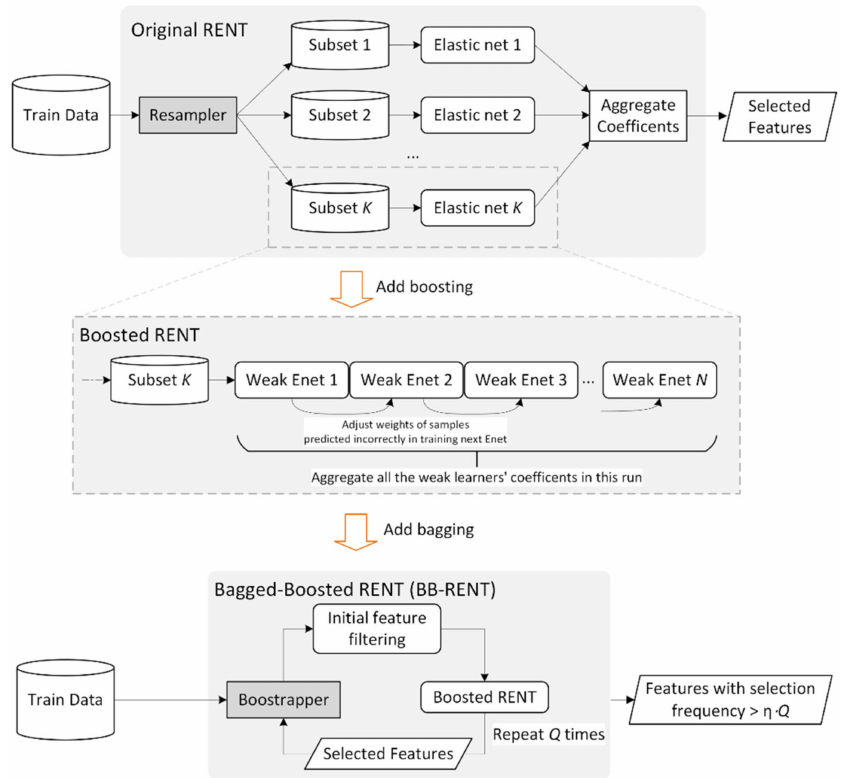
Figure 3. Illustration of the original repeated elastic net technique (RENT), a technique previously reported in [17], and the proposed bagged-boosted RENT (BB-RENT) technique based on it. K , N , Q , and η are hyperparameters of the algorithm, where K is the number of times the elastic net or the boosted elastic net is repeated, N decides the maximum number of weak learners (depth) used when boosting the elastic nets, Q decides the number of times the boosted RENT is bootstrapped and then aggregated, and η is the percentage threshold for including a feature in the final selected subset. Enet = elastic